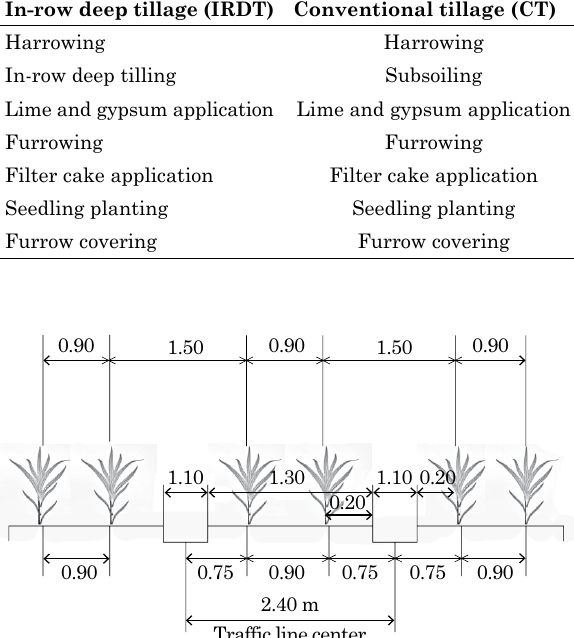
table 1. description of both soil tillage systems in an area of Latossolo Vermelho (oxisol) in-row deep tillage (irdt) Conventional tillage (Ct) Harrowing